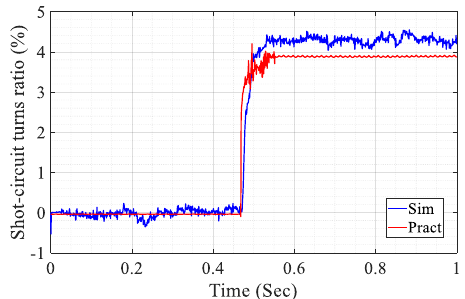
Figure 24. Estimation of 4% short circuit turns ratio in phase A.